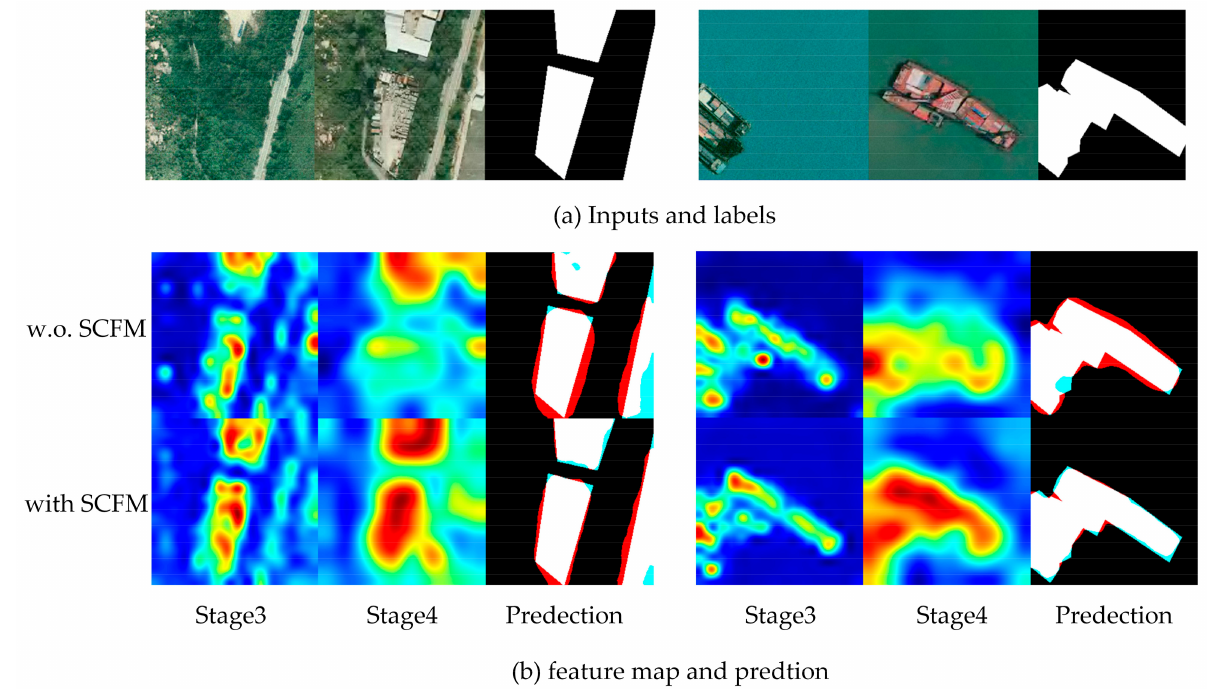
Figure 10. Visualization of SCFM module features.